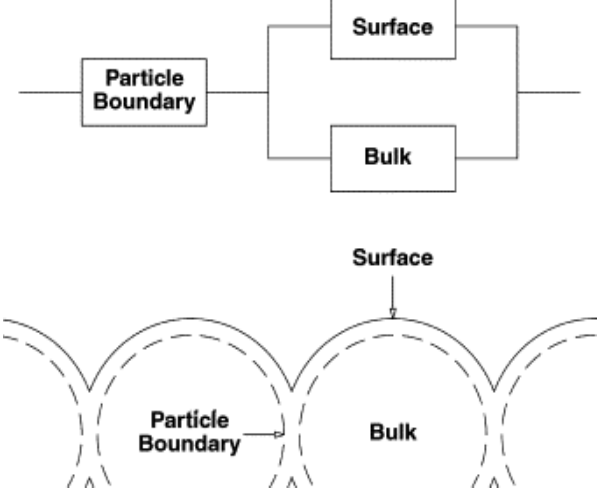
Figure 2. Demonstrating the structure of the materials, and the positions of the surface, bulk and particle boundary. Figure adapted with permission from Naisbitt et al .